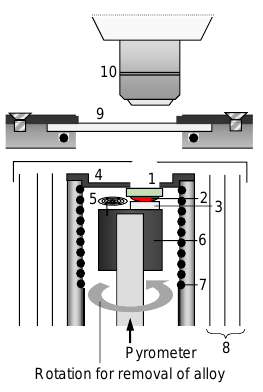
Figure 1. Experimental apparatus for in situ observation of SiC/alloy interface: (1) on-axis 4H-SiC {0001} (80 μ m in thickness), (2) molten alloy, (3) Al 2 O 3 plate, (4) substrate holder, (5) Ta assembly (for removal of alloy), (6) graphite holder, (7) spiral wire heater, (8) reflectors, (9) quartz window, and (10) objective lens.